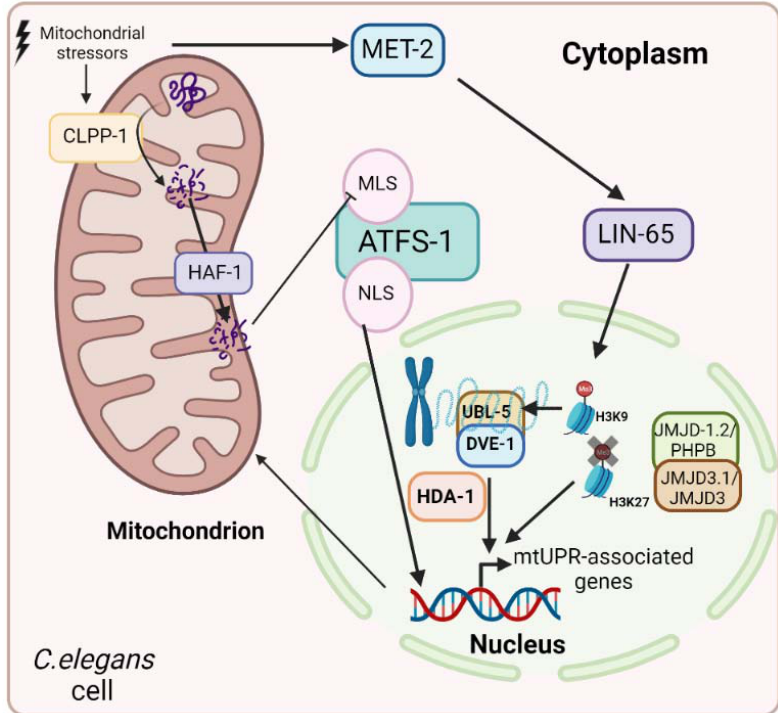
Figure 2. mtUPR in C.elegans. When mitochondrial stressors are present, the proteolytic complex CLPP ‐ 1 is activated, causing the degradation of proteins to smaller peptides. Then, HAF ‐ 1 transports them to the intermembrane space, where the accumulation of small peptides causes the inhibition of ATFS ‐ 1 translocation to the mitochondria and its transport to the nucleus, where it activates the transcription of stress response genes. Moreover, there are other factors implicated in mtUPR regulation. Epigenetic modifications, such as methylation and acetylation, are involved in it. In stressful mitochondrial situations, the methylase MET ‐ 2 is activated and promotes the translocation of LIN ‐ 65 to the nucleus, where it methylates H3K9, promoting chromatin condensation. However, while most of the chromatin is silenced, some parts of it are opened, and it is in those parts where the complex formed by DVE ‐ 1 and UBL ‐ 5 binds to and activates the transcription of mtUPR ‐ related genes. Otherwise, the lysine demethylases, JMJD ‐ 1.2/PHPB and JMJD ‐ 3.1/JMJD3, form a complex that demethylases H3K27, promoting the opening of chromatin and the transcription of mtUPR ‐ associated genes. Finally, the histone deacetylase HAD ‐ 1 promotes the transcription of mtUPR ‐ related genes via the activation of DVE ‐ 1.